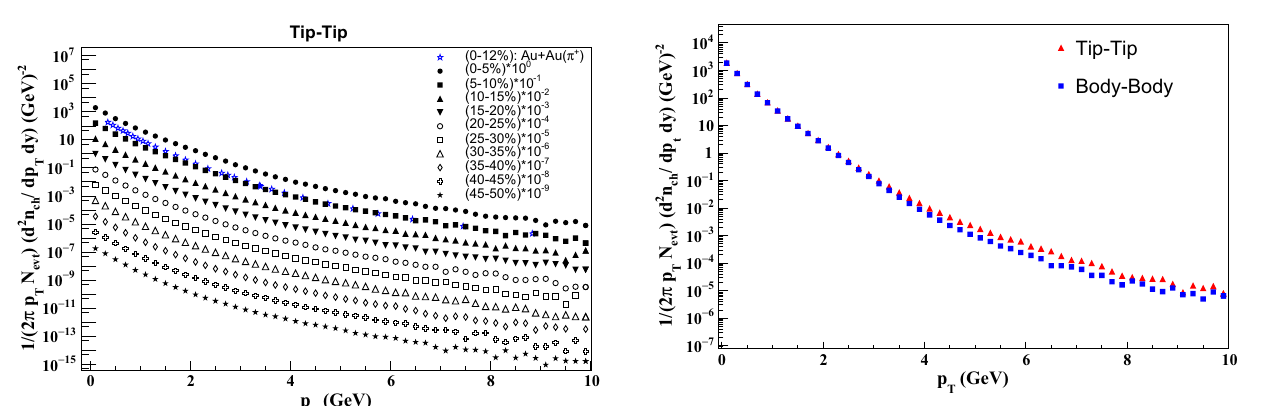
configuration with respect to p T for various centrality classes. The central Au + Au data for charged pions almost matches with the scaled U + U result of 5–10% centrality class at intermediate p T range. However, at low and high p T range, the multiplicity is larger in Au + Au collision than the body–body configuration of U + U collision. In body–body configuration (see Fig. 18), the slope of distribution is more in comparison to tip–tip configuration for given centrality class due to the effect of transverse flow. The difference of p T distribution for both the configurations can be seen at inter- mediate and large p T region for central collision. As shown in Fig. 19, for most-peripheral collisions there is small differ- ence between tip–tip and body–body configurations in low p T region only. As we know that most of the low- p T par- ticles are due to thermal production and high- p T particles are due to jet fragmentation. Thus, in peripheral collision the initial configuration of nuclei affects the thermal part